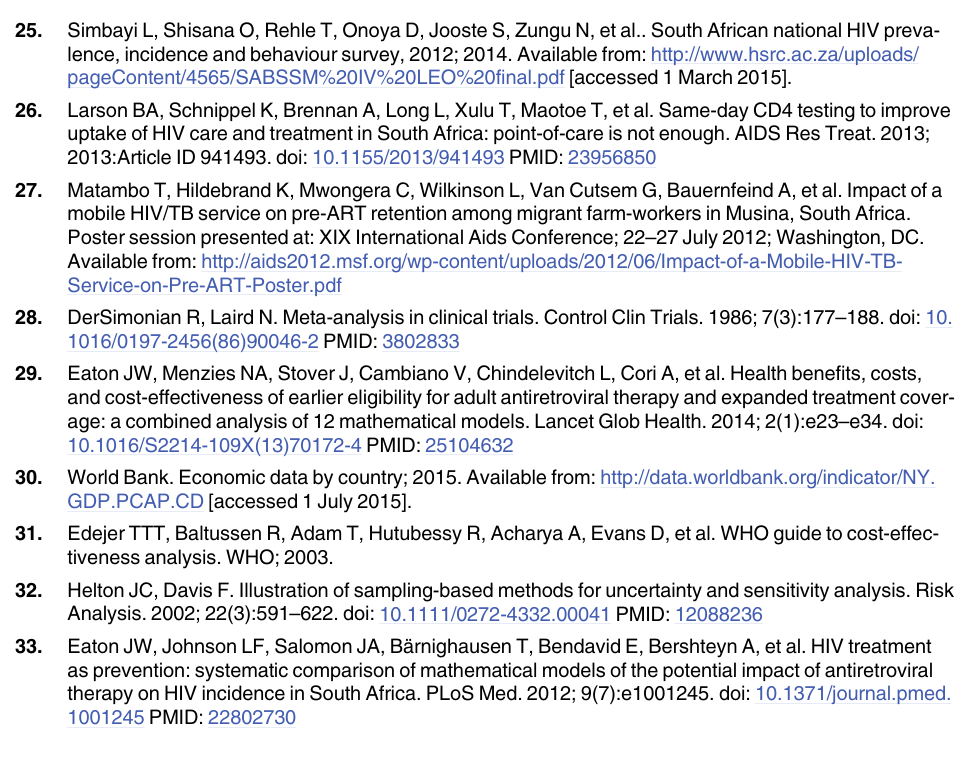
PLOS ONE | DOI:10.1371/journal.pone.0158303 July 8,